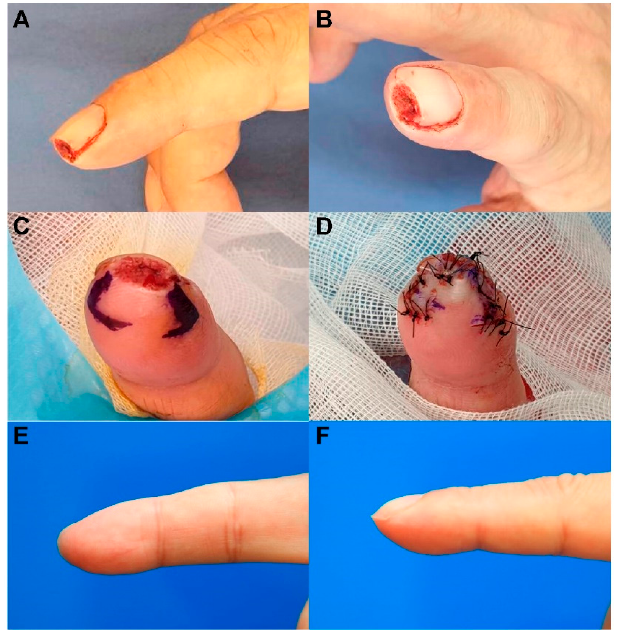
Figure 3. Clinical photographs of a 47-year-old man who sustained a right second fingertip injury while using a cutter knife. ( A , B ) A tiny volar pulp defect of the right second fingertip (0.6 cm × 1 cm). ( C ) Design of a modified mini-keystone flap (m-KF) (0.8 cm × 1.5 cm). ( D ) Successful coverage of the defect with the modified m-KF. ( E , F ) Postoperative photographs obtained at the 6-month